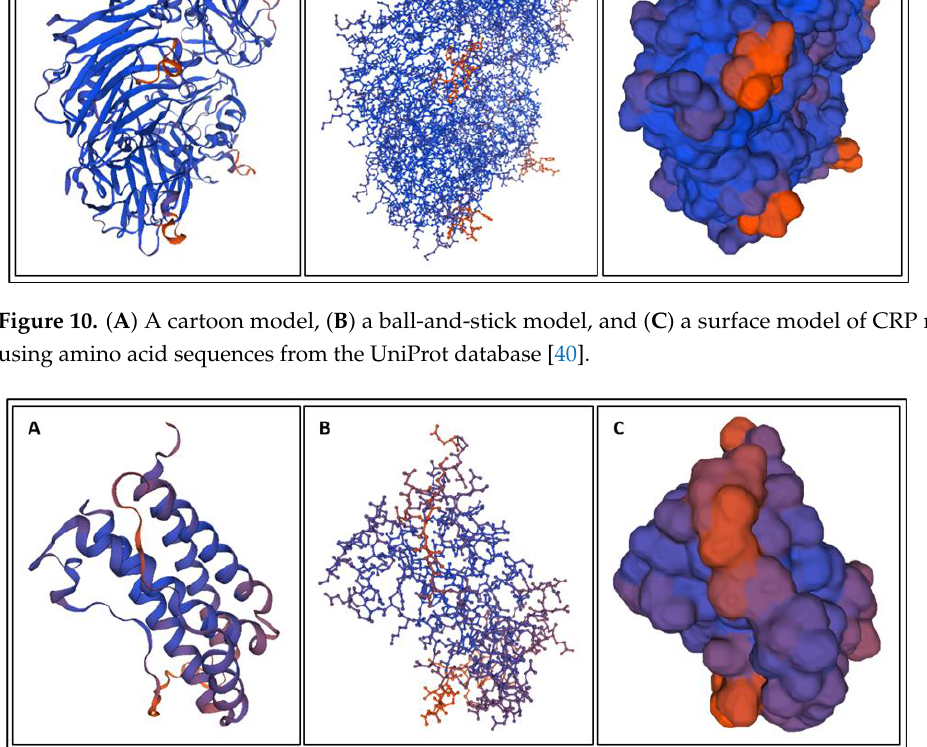
Figure 11. ( A ) A cartoon model, ( B ) a ball-and-stick model, and ( C ) a surface model of IL-6 made using amino acid sequences from the UniProt database [42].